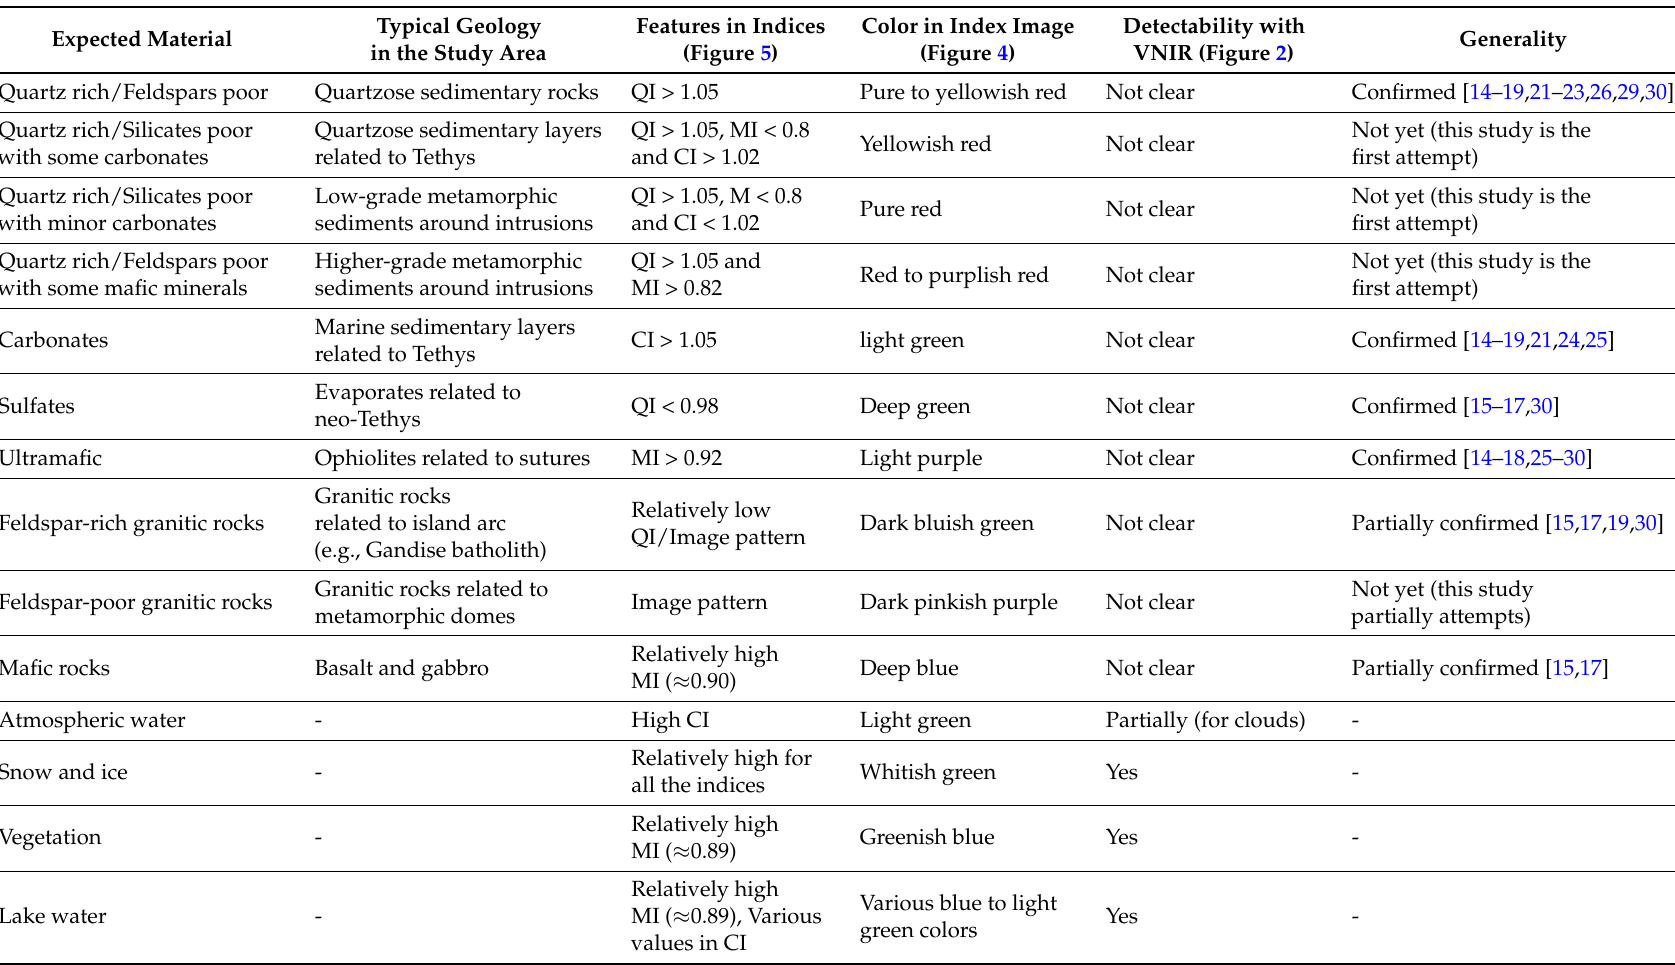
Table 1. Characteristics of the indices for geological and other